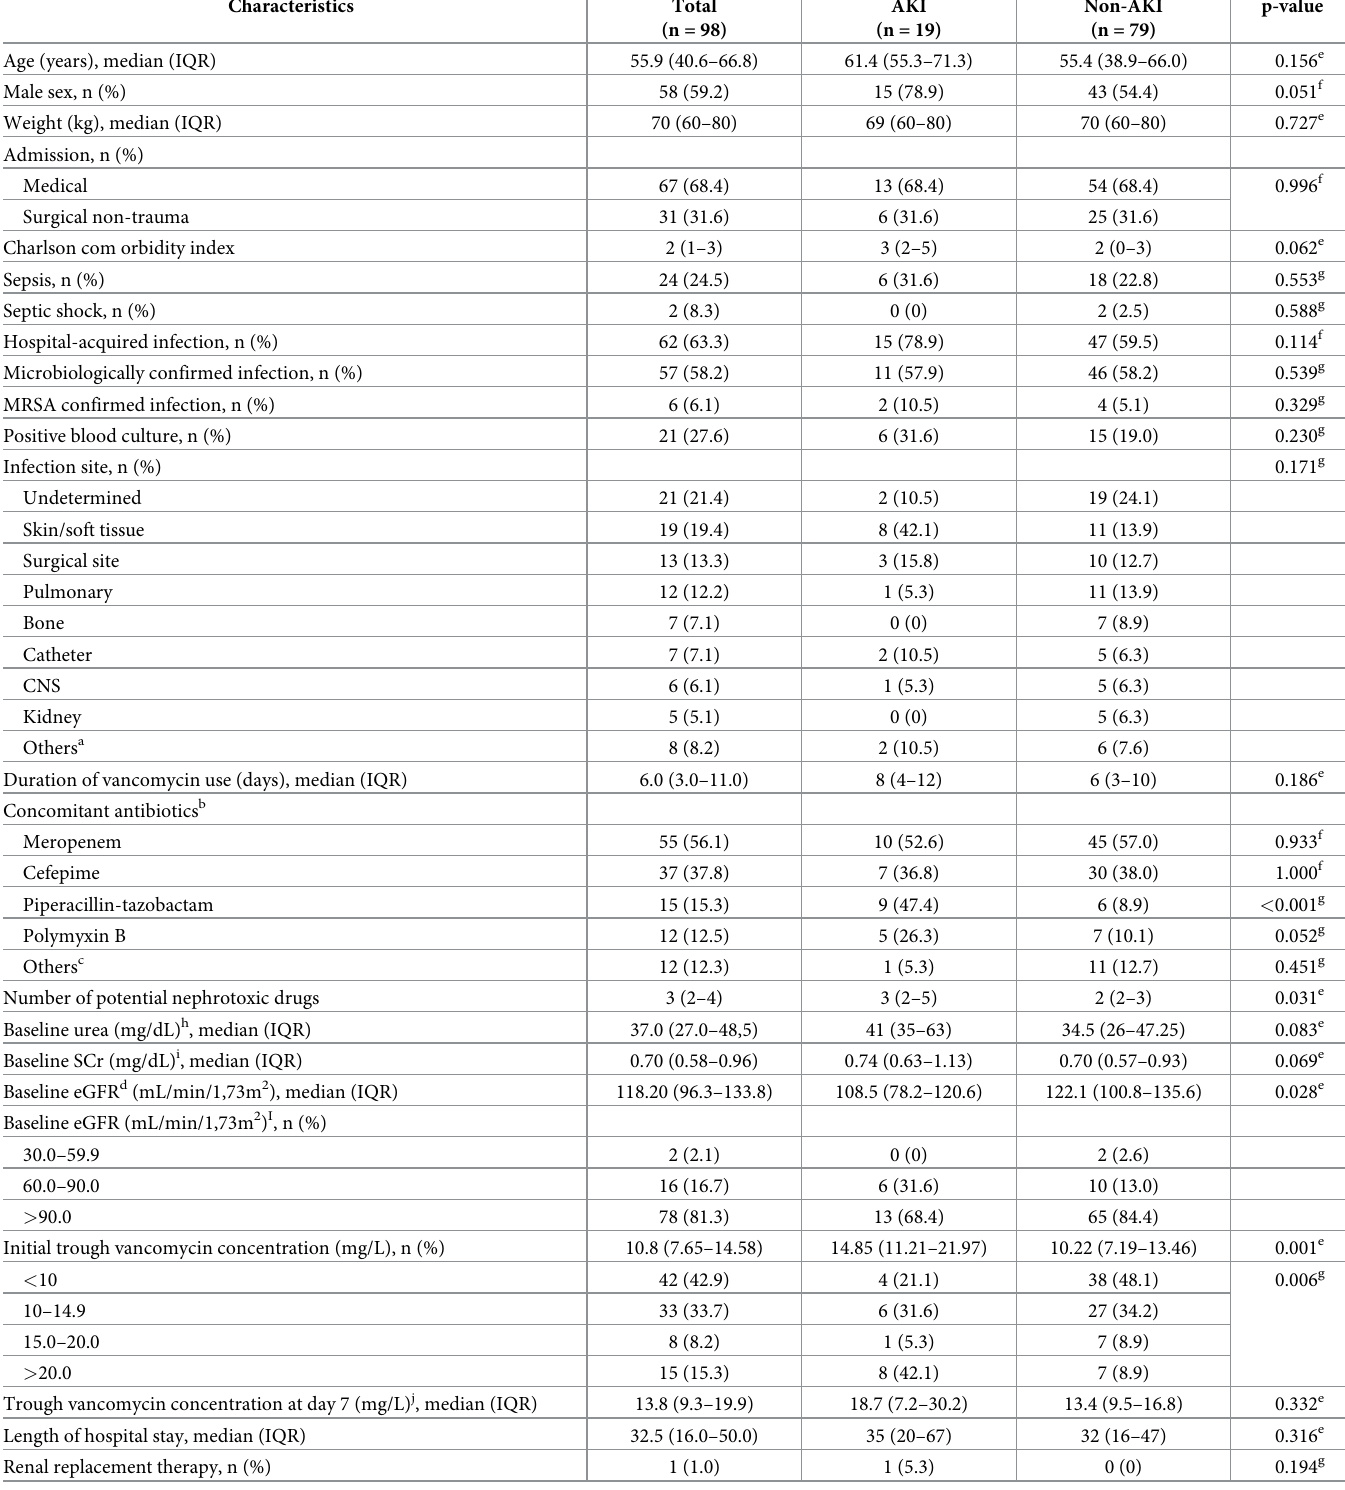
Table 1. Descriptive data of study participants and comparison between AKI and non-AKI